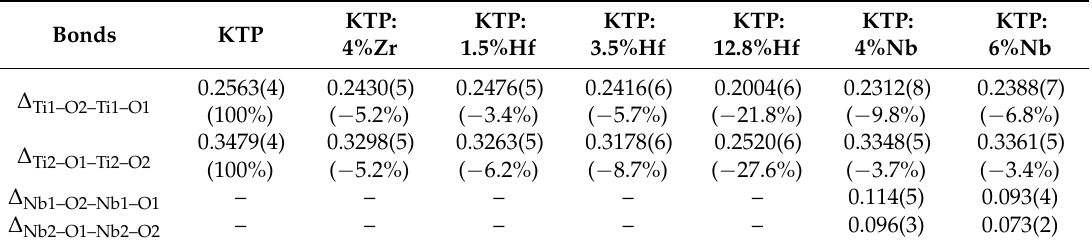
Table 4. Difference of lengths of titanyl bonds in the structures of pure KTP [46],